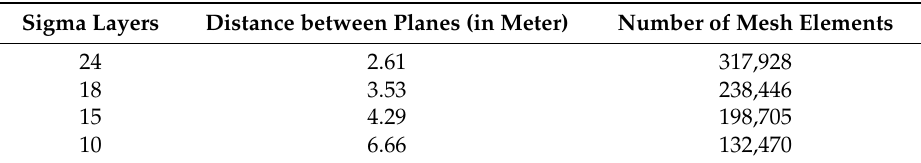
Table 4. Comparison of the vertical resolutions.